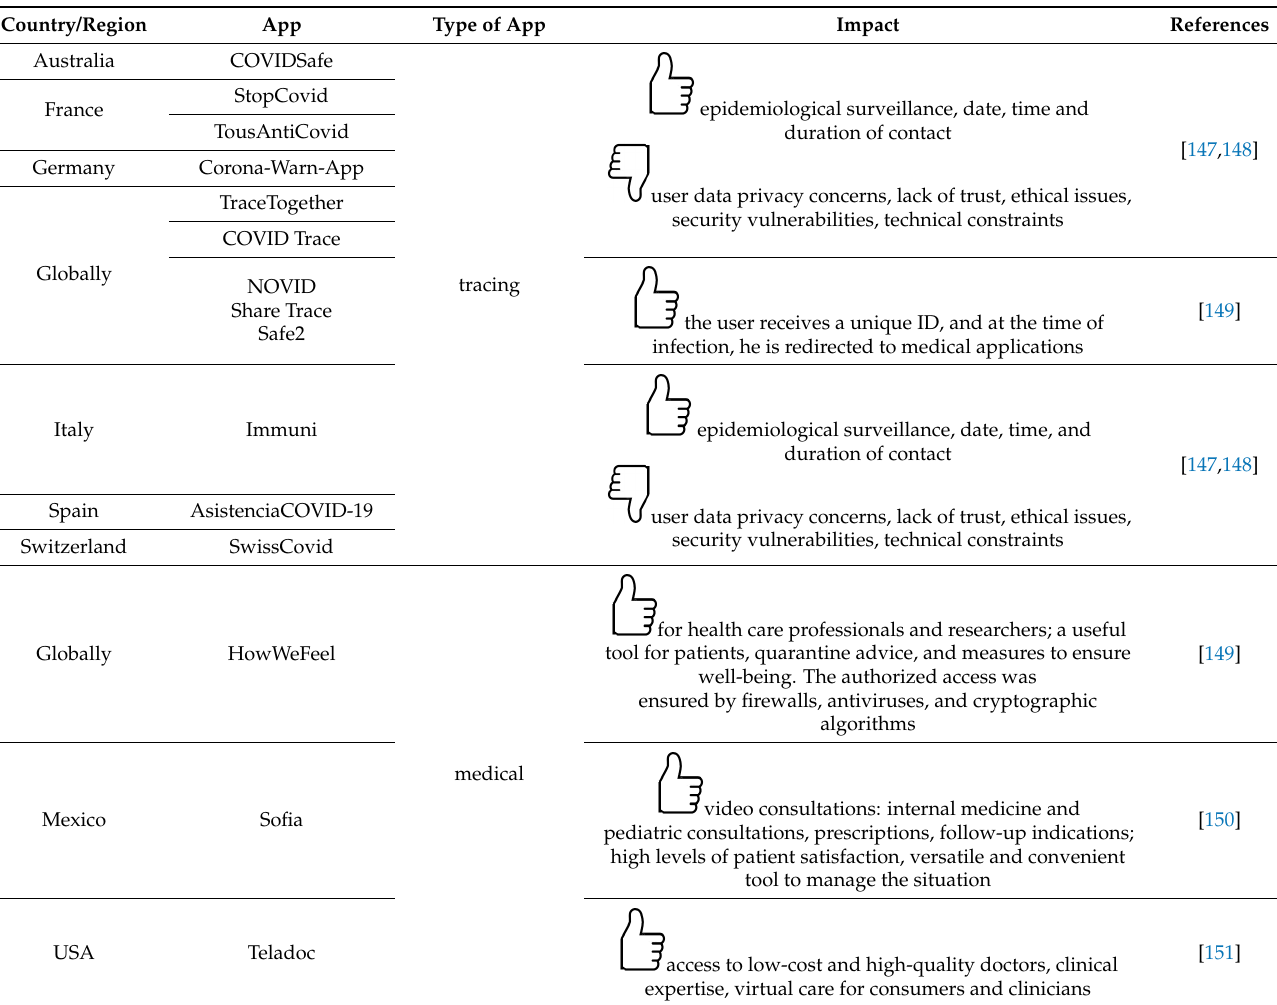
Table 2. Examples of mHealth apps developed by government agencies for contact tracing and information delivery to curtail the spread of C19.